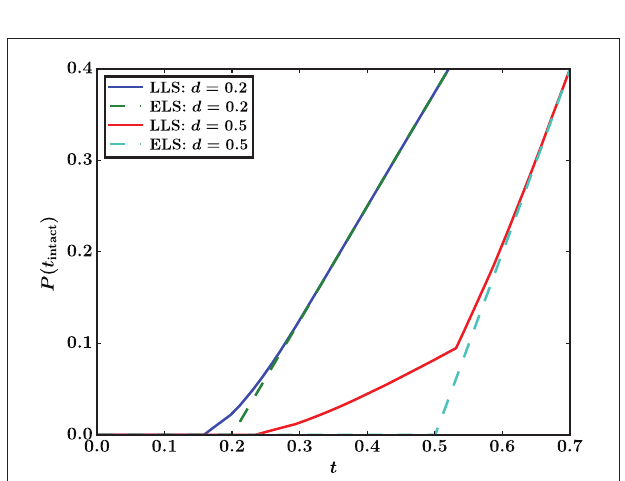
Figure 3 contrasts the load sharing factor for ELS and LLS.